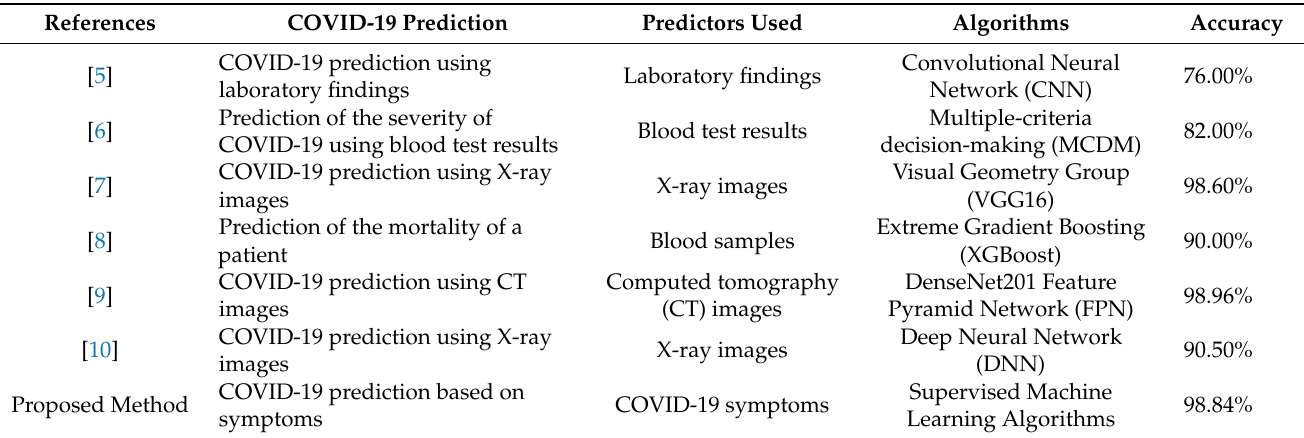
Table 1. Table 1. COVID-19 Prediction